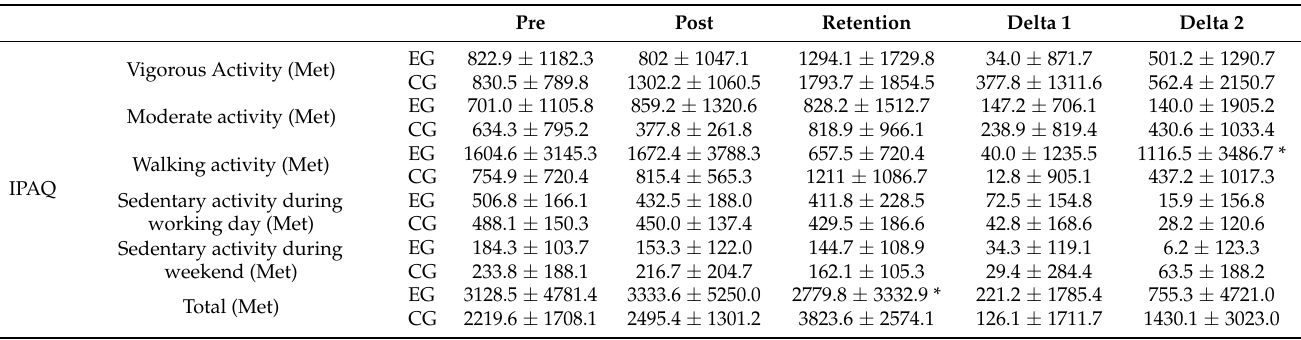
Table 2. Results of IPAQ performed before the intervention (pre), at the end of the intervention (post) and 4 weeks after the end of the intervention